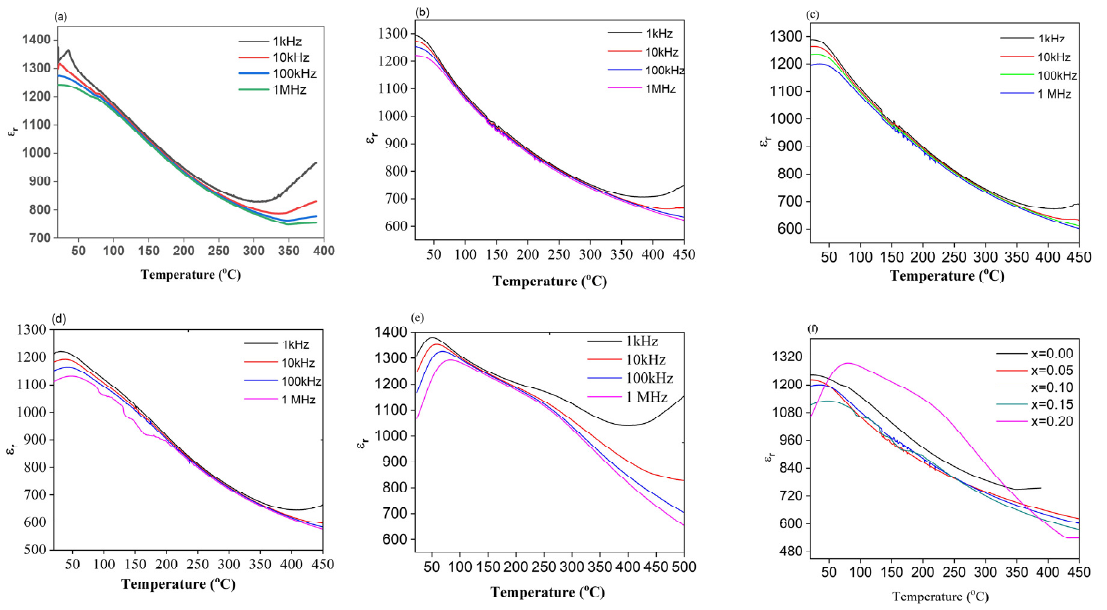
Figure 3. Changes in ε r for (NBT-BT-NBN 1 − x T x ) ceramic compositions: ( a ) x = 0.00, ( b ) x = 0.05, ( c ) x = 0.10, ( d ) x = 0.15, and ( e ) x = 0.20, as a function of the temperature at different frequencies. ( f ) Variations in ε r for (NBT-BT-NBN 1 − x T x ) ceramic compositions (x = 0.00, 0.05, 0.10, 0.15, 0.2) vs. temperature at 1 MHz.